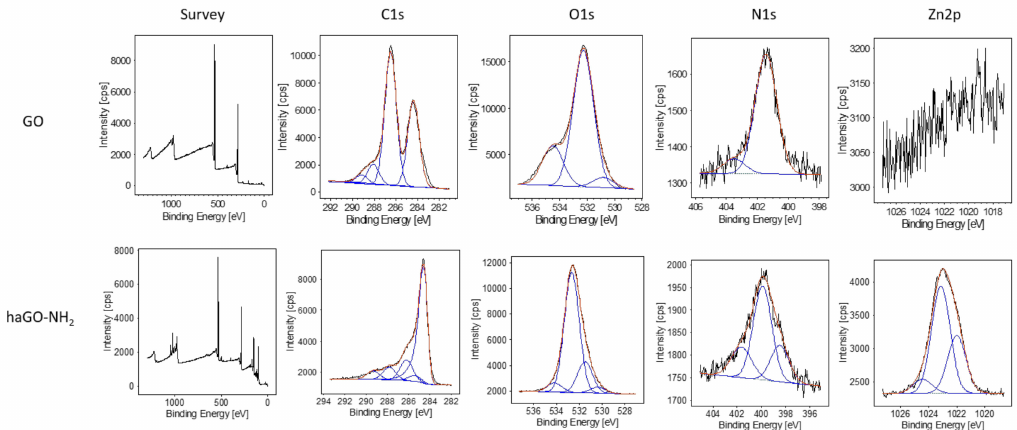
Figure 1. X-ray Photoemission Spectroscopy.The elemental composition of the nanoparticles was analyzed by X-ray photoemission spectroscopy (XPS) on Axis DLD Ultra instrument (Kratos–Manchester,